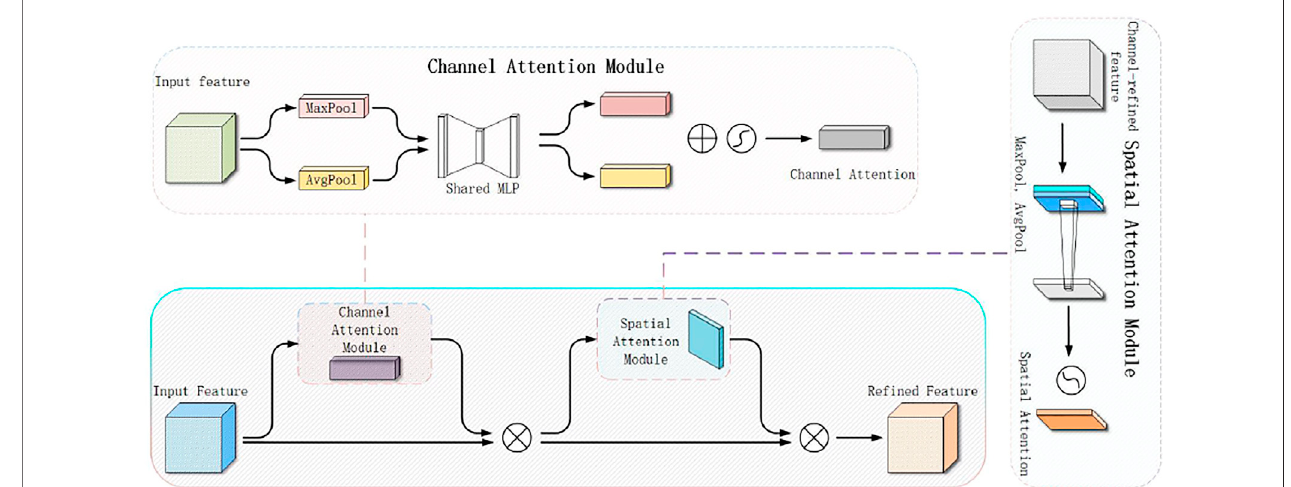
FIGURE 4 | Convolutional block attention module.